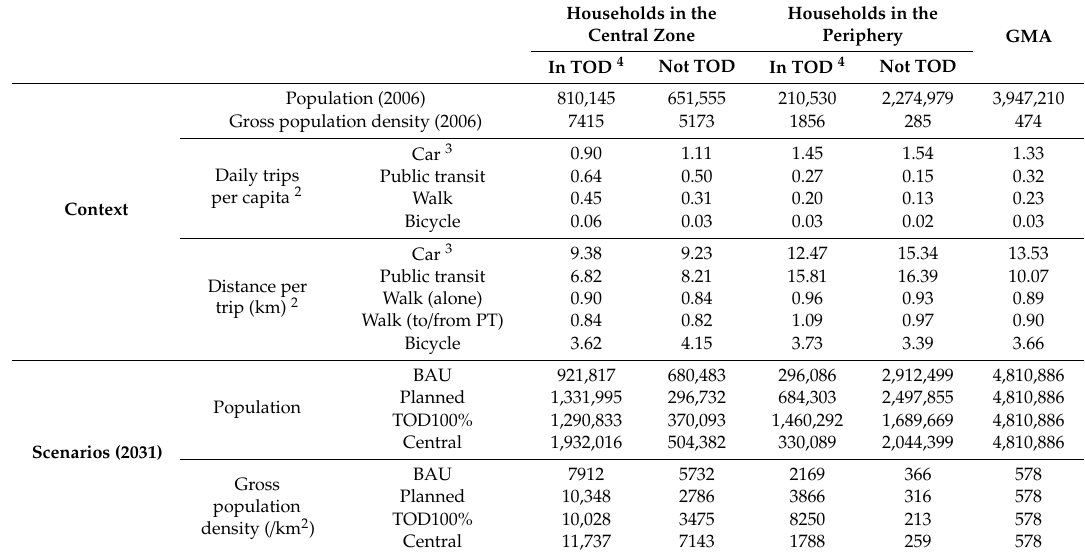
Table 2. Travel behavior, population distribution and density 1 according to residential location in the Greater Montreal Area.